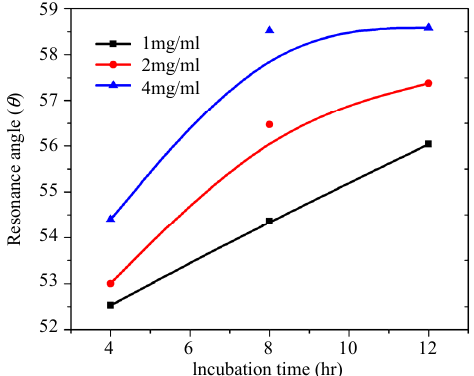
Fig. 6 Antibody immobilization optimization on the sensor